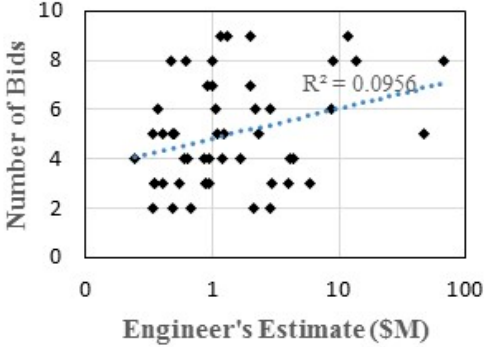
Figure 3. Heatmap of project distribution in respect to the number of bids and the engineer’s estimate.